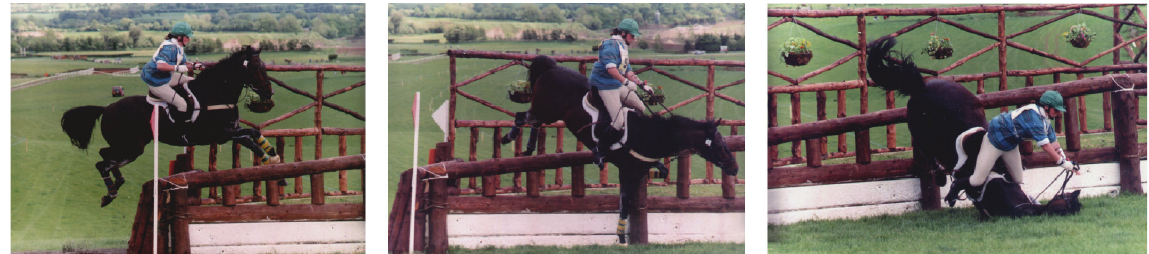
Figure 3: Some fence designs may challenge not only the athletic prowess of the performance horse but also the visual capability of the animal, which may have safety implications for both horse and